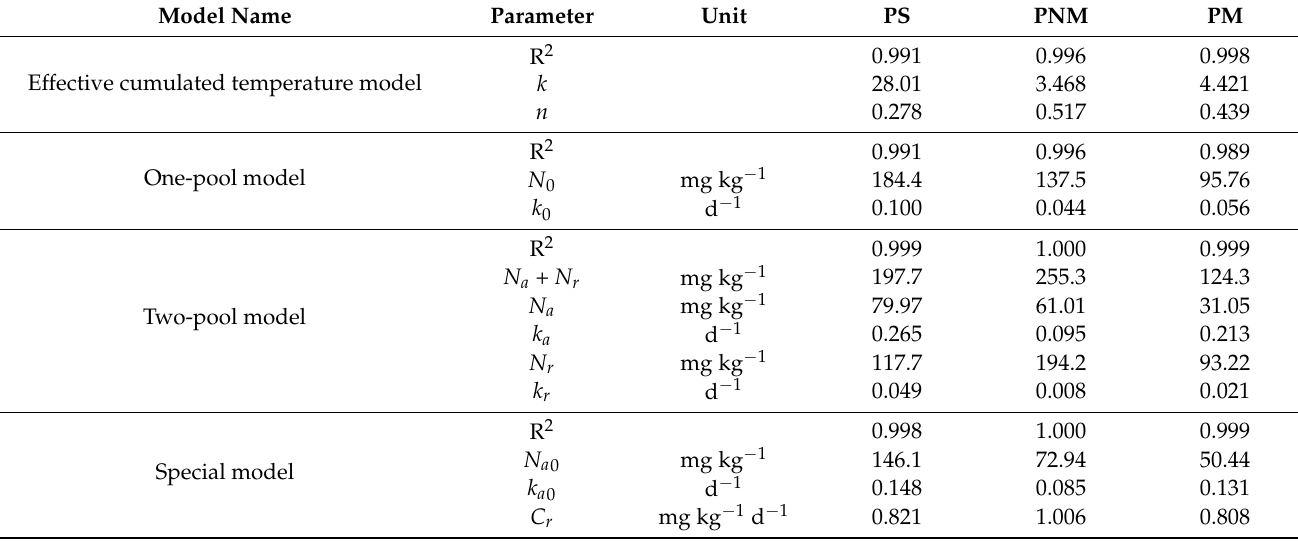
Table 3. Estimated parameters of four different models and their goodness-of-fit (R 2 ) obtained from nonlinear regressions.